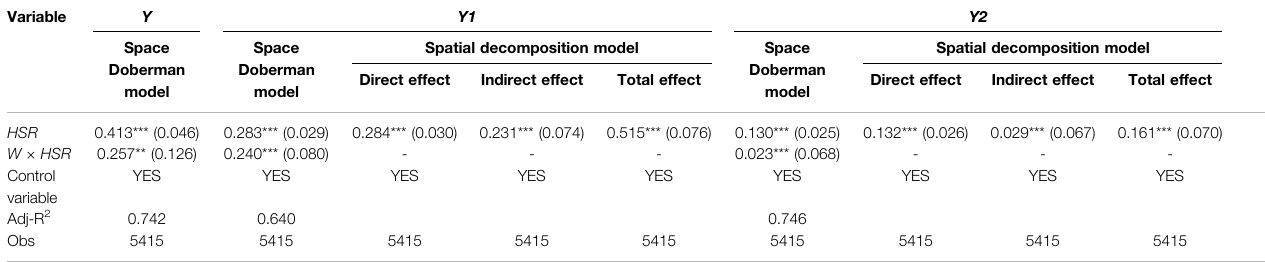
TABLE 1 | Benchmark regression results.